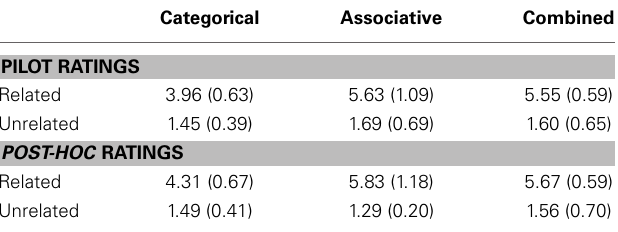
Table 1 | Association strength (means and standard deviations) from the pilot and post-hoc experimental